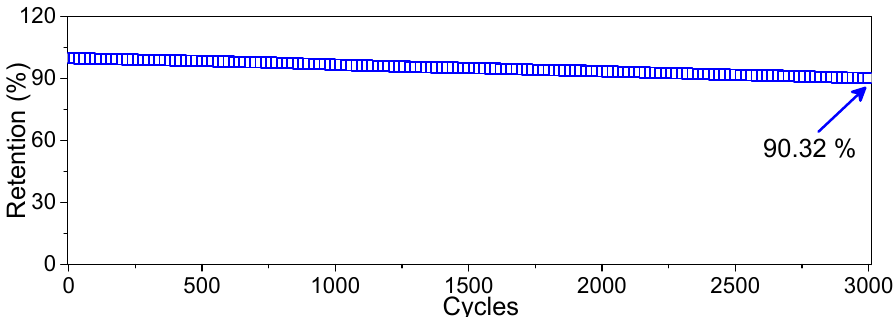
Figure 9. Capacitance retention vs. cycles number over 3000 cycles.